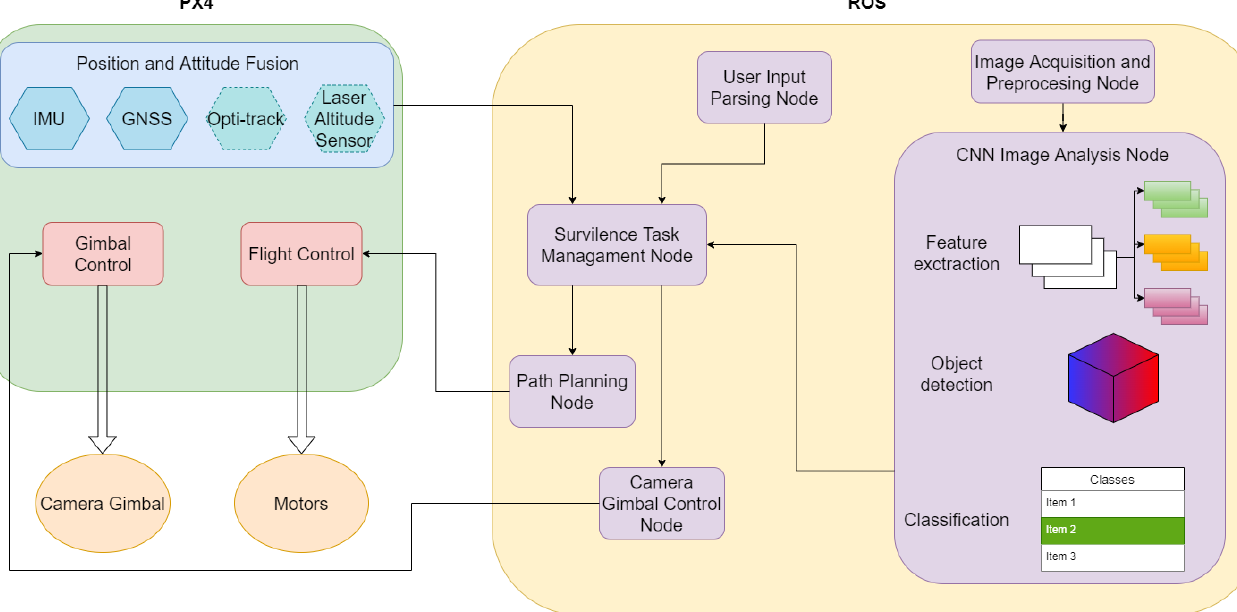
Figure 2. System architecture used in the